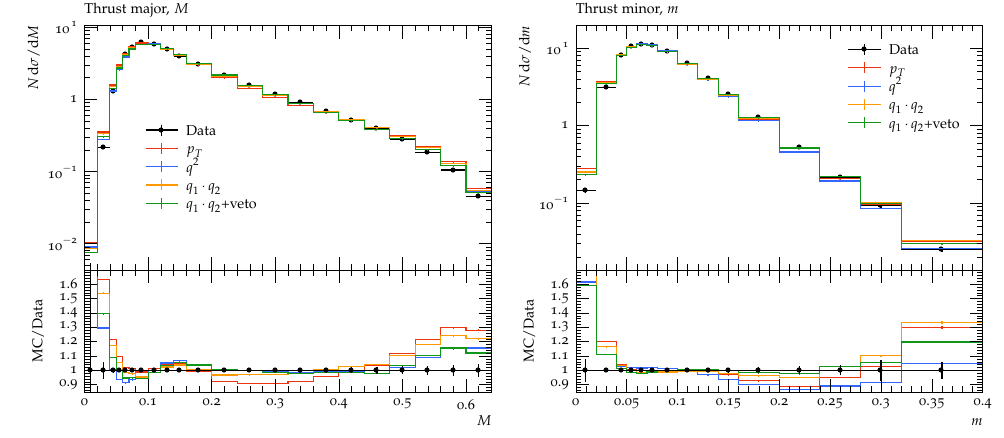
Figure 5 . Thrust major (left) and minor (right) at the Z-pole compared with data from the DELPHI [44]